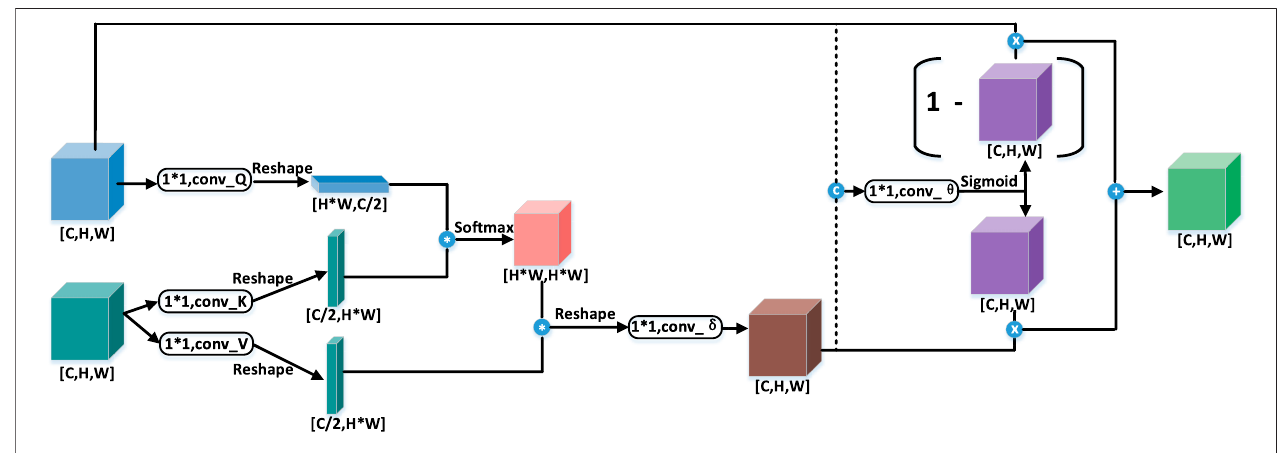
FIGURE 5 | The model receives inputs at two different scales and undergoes different convolution operations to generate the Query block, Key block and Value block, respectively. The weighted feature maps are generated by the Query and Key modules, and then multiplied with the Value module to generate the attention- passed feature maps. Finally, the fi nal feature map is generated by mask branching.